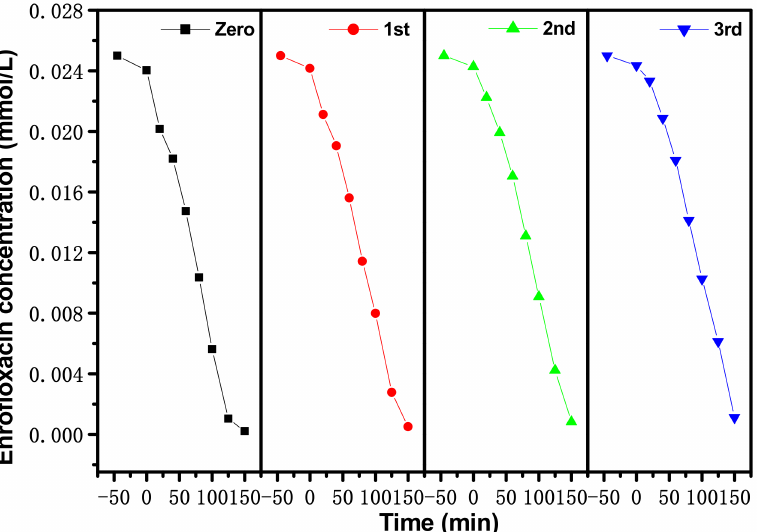
Figure 14. Concentration change curves of ENR during PCD of ENR within pharmaceutical waste water with EBH as photocatalyzer under VLGI for three recursion retrogradation